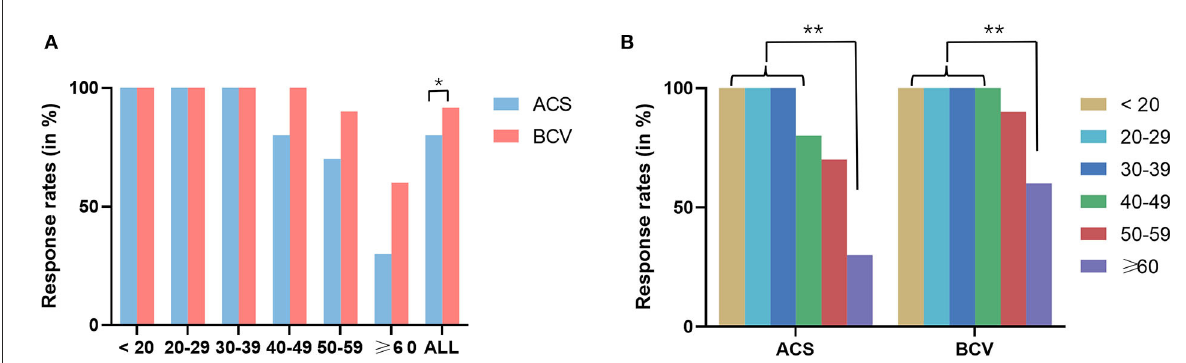
FIGURE2 (A) Comparison of response rates between ACS and BCV oVEMPs in different age groups using Pearson’s chi-square test and Fisher’s exact test. (B) Comparison of response rates between different groups of age in ACS and BCV using Fisher’s exact test with Bonferroni adjusted multiple comparisons for pair-wise comparisons. Star-marked comparisons are statistically significant at * p < 0.05 and ** p <